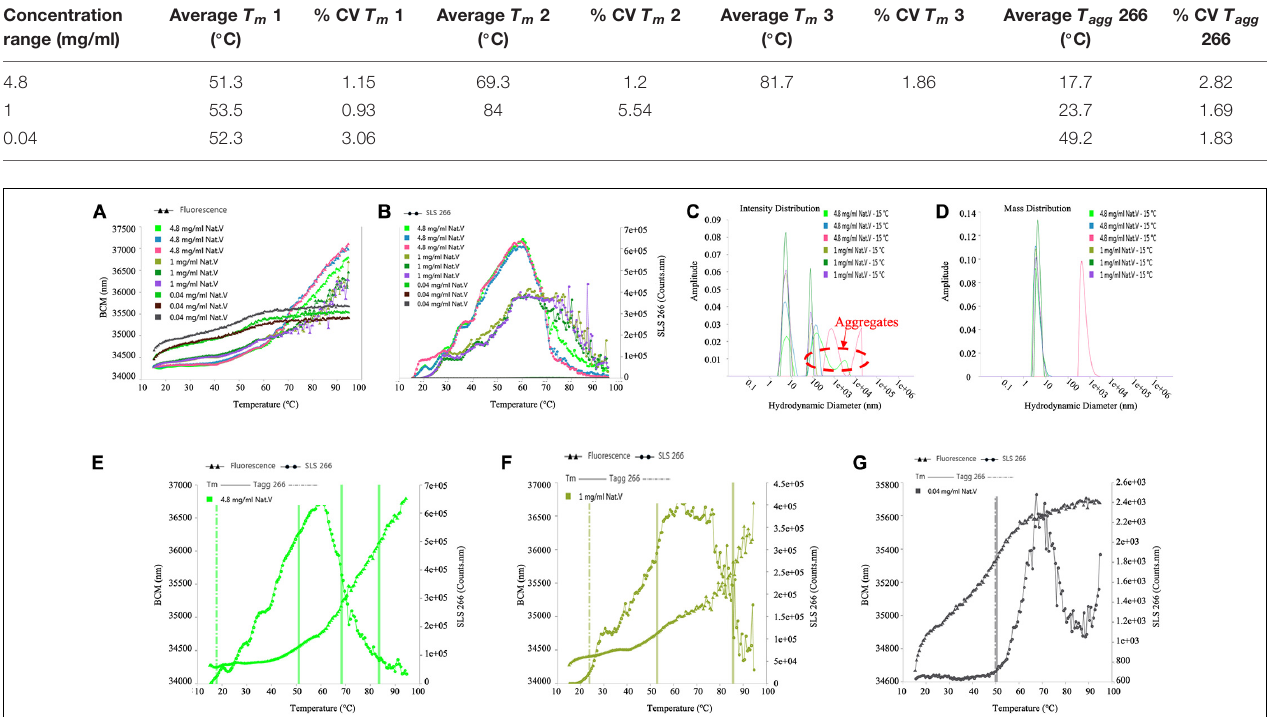
FIGURE 7 | Determination of the T m , T agg and size distribution of (VIBVN)NAT. (A) Depicts T m value by denaturation curve. (B) Depicts T agg value by aggregation curve. (C) Intensity Distribution. (D) Mass Distribution. (E–G) Depicts the relationship between denaturation and aggregation at different